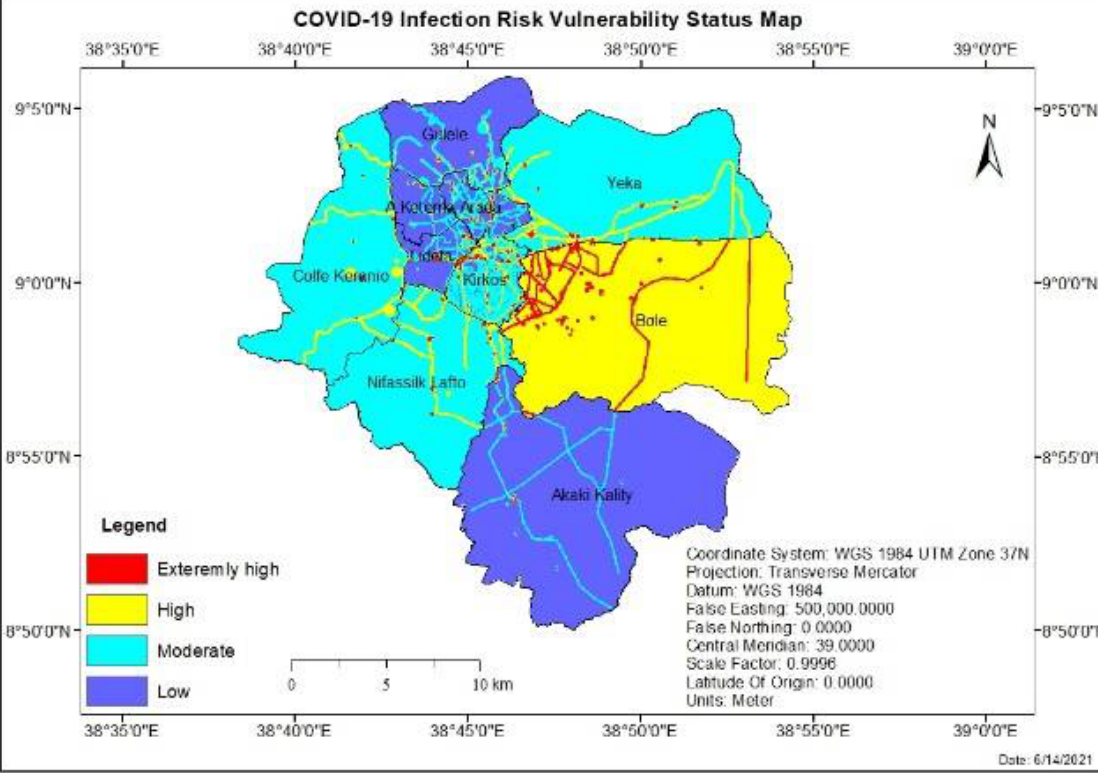
Figure 5. COVID-19 Infection risk vulnerability status map in Addis Ababa.